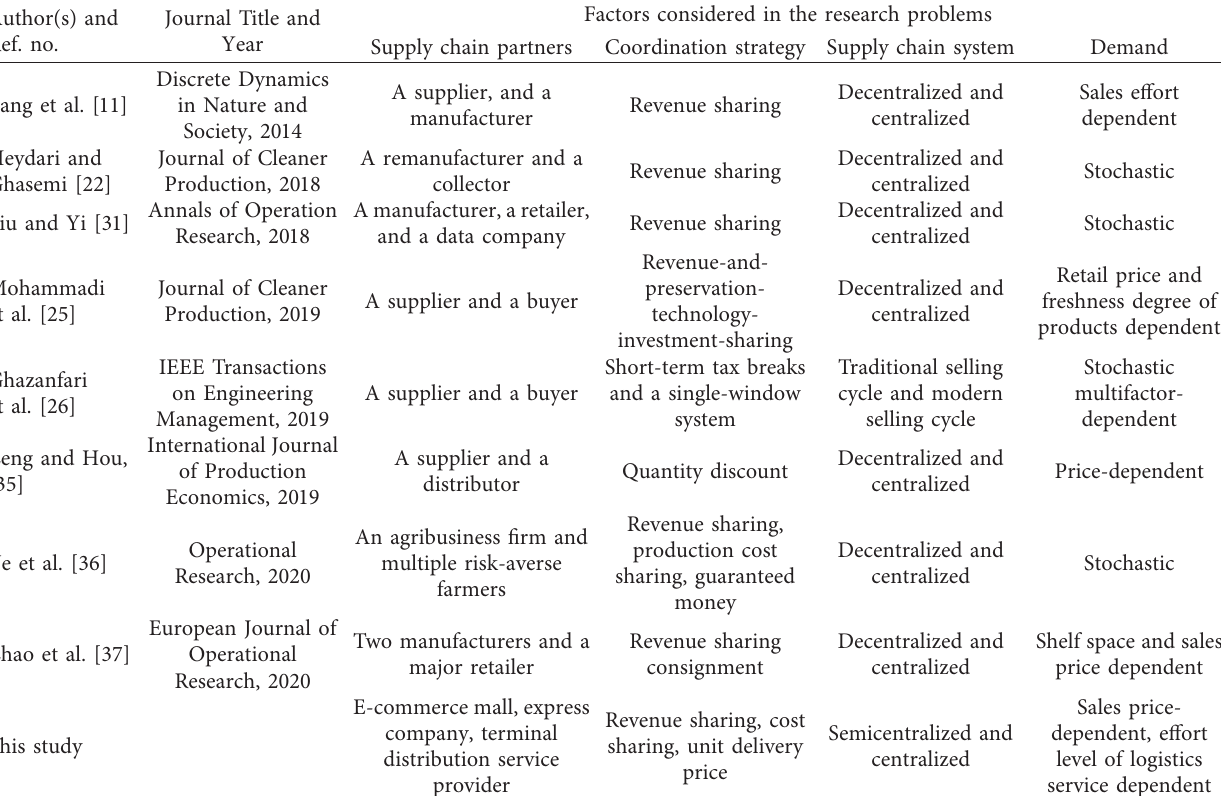
Table 1: List of key-related literatures.